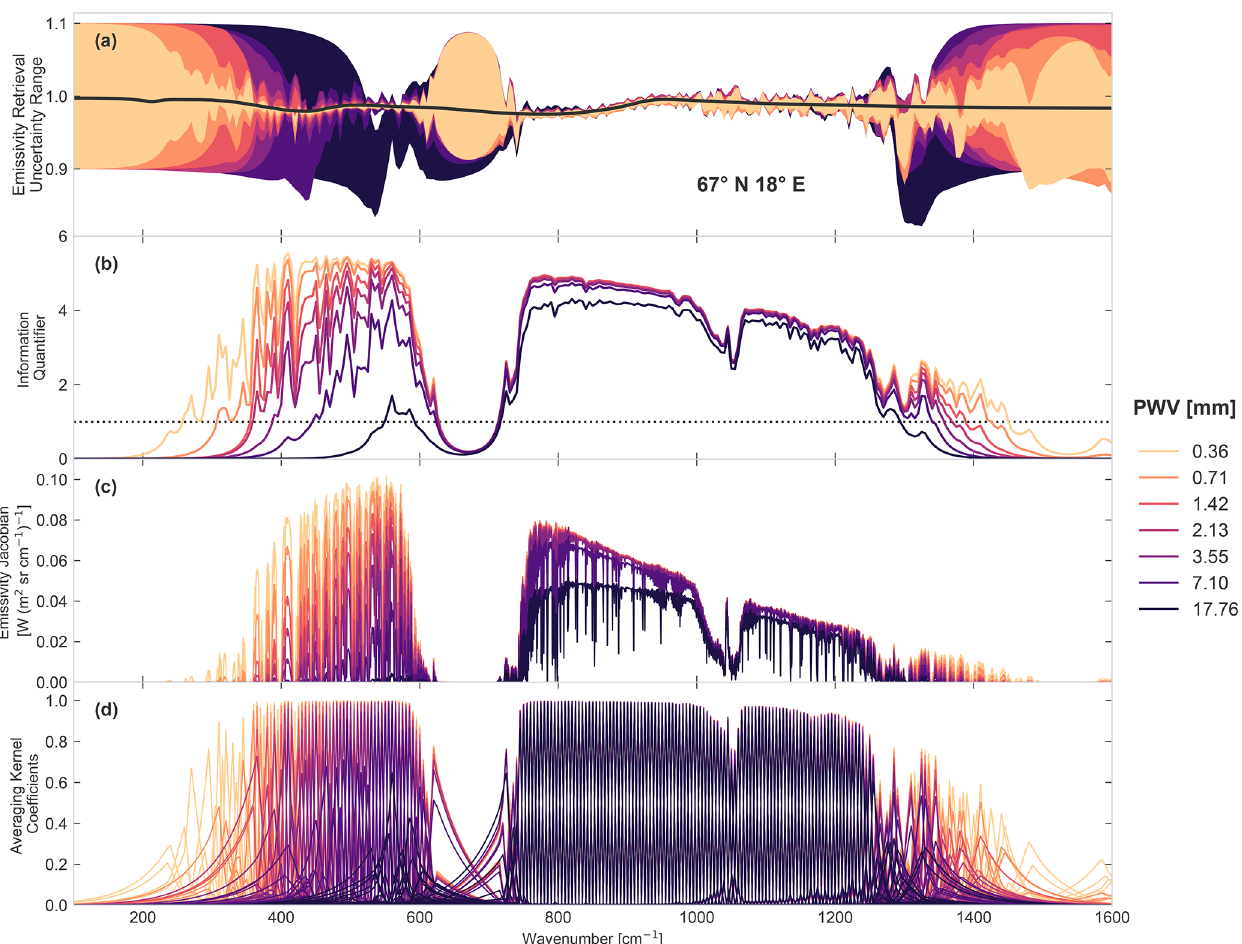
Figure 4. The same retrieval as in Fig. 3 is run for scene 67 ◦ N, 18 ◦ E with modified precipitable water vapour (pwv) content, and the same quantifiers are shown as in Fig. 3. Panel (a) shows the ± 1 σ emissivity retrieval uncertainty range as a shaded coloured region and the true emissivity as a black line, and panels (b) – (d) are the same as in Fig. 3. The colours from dark to light indicate the true pwv content of the retrieved scene from high to low, and the exact pwv values are marked on the colour scale to the right of the